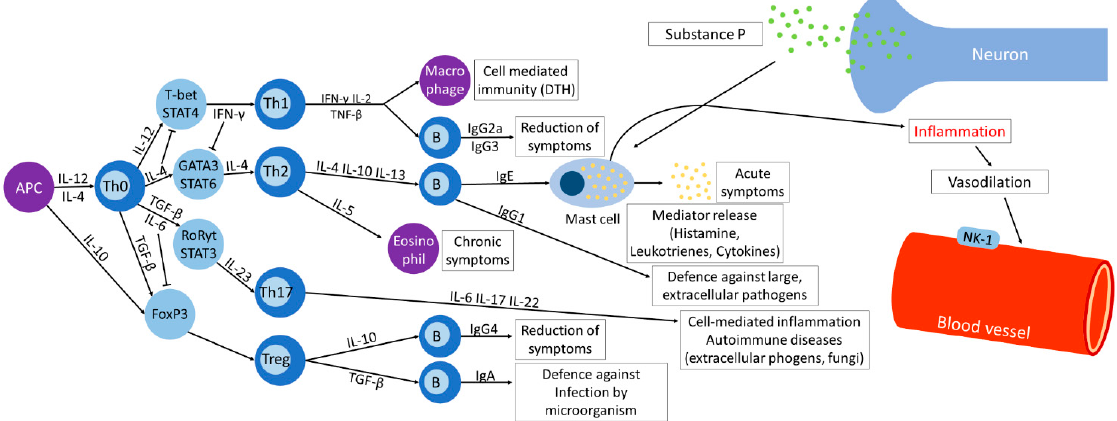
Figure 1. The mechanism of allergic rhinitis (AR) symptoms triggered by APC. APC, antigen-presenting cell; IL, interleukin; Th, T helper; T-bet, T-box-expressed-in-T-cells; STAT, signal transducers and activators of transcription; TGF, transforming growth factor; RoRyt, retinoid-related orphan receptor; FoxP3, Forkhead box p3; IFN, interferon; Treg, regulatory T; DTH, delayed type hypersensitivity; Ig, immunoglobulin; NK-1, neurokinin-1 receptor.